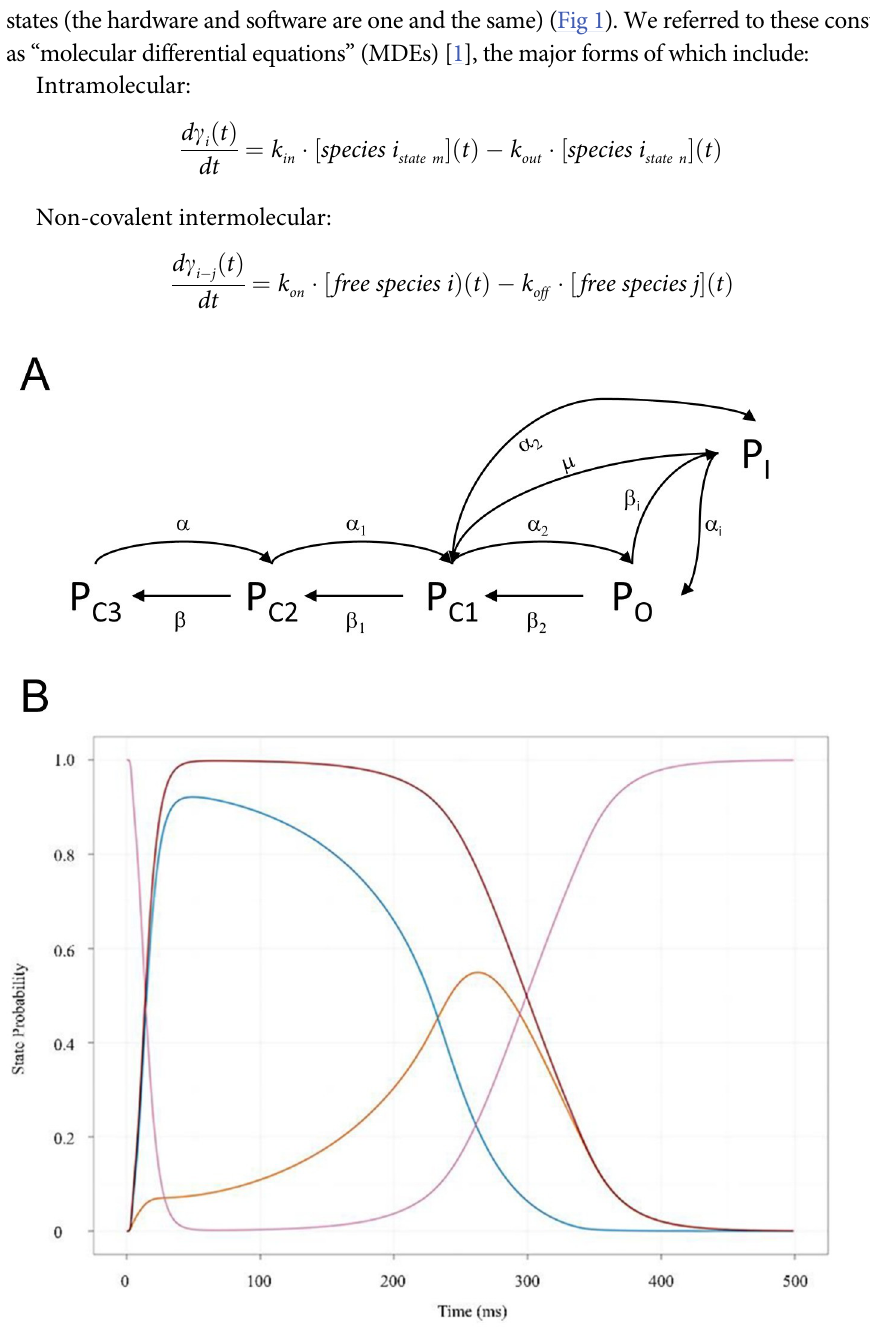
Fig 1. (A) Markovian state transition behavior exemplified for the human cardiac ether-a-go-go related gene (hERG) potassium channel between closed (C1, C2, and C3), open (O) and inactivated states (I) underlying the state probability curves in (B) [4]. The rate constants are labeled with Greek letters. (B) Molecular populations of hERG “flow” from one specific state to another based on intrinsic voltage-dependent rates of entry and exit. Multiple fluxes occur in parallel between specific states, speeding and slowing in response to dynamic perturbations. For example, the open (orange) and inactive (blue) states are fed by the closed state (magenta); the open and closed states are fed by the inactive state; and the inactive and closed states are fed by the open state. The time-dependent output of the overall system (i.e. the membrane potential in this case) is solved in cardiomyocytes via integration of the full complement of sodium, potassium, and calcium ion channel MDEs (which can be simulated using the O’Hara-Rudy model of the human cardiac AP [5]).